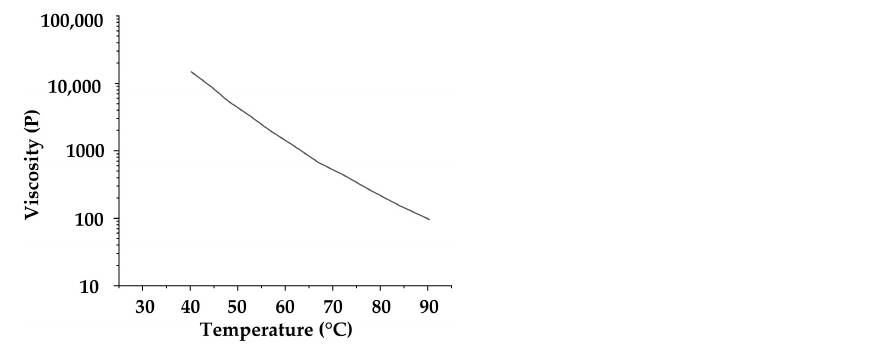
Figure 5. The relationship between resin viscosity and temperature in the exponential coordinate